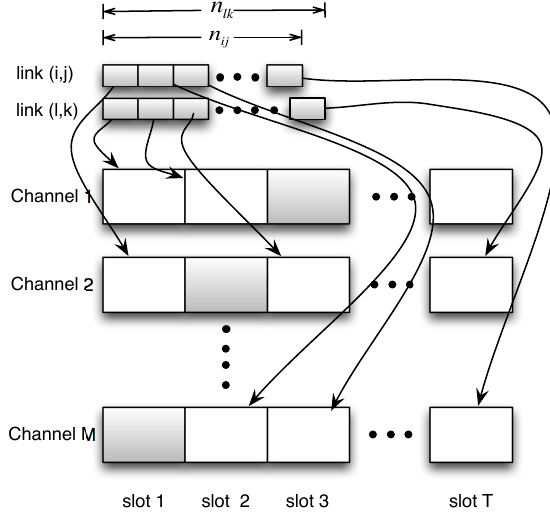
Figure 1. Illustration of the balanced partition modeling for measurement